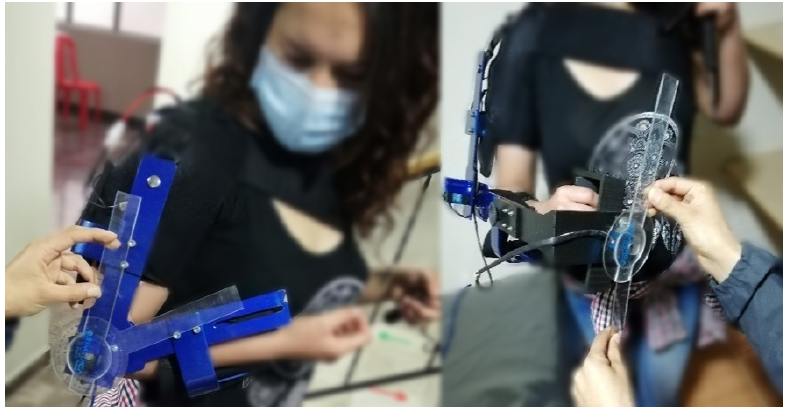
Figure 9. Prototype orthosis to support upper torso rehabilitation in case study.